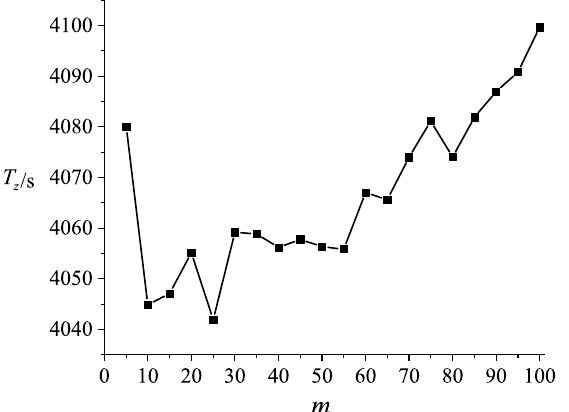
Figure 10. Relationship between total time T z and ant population m .